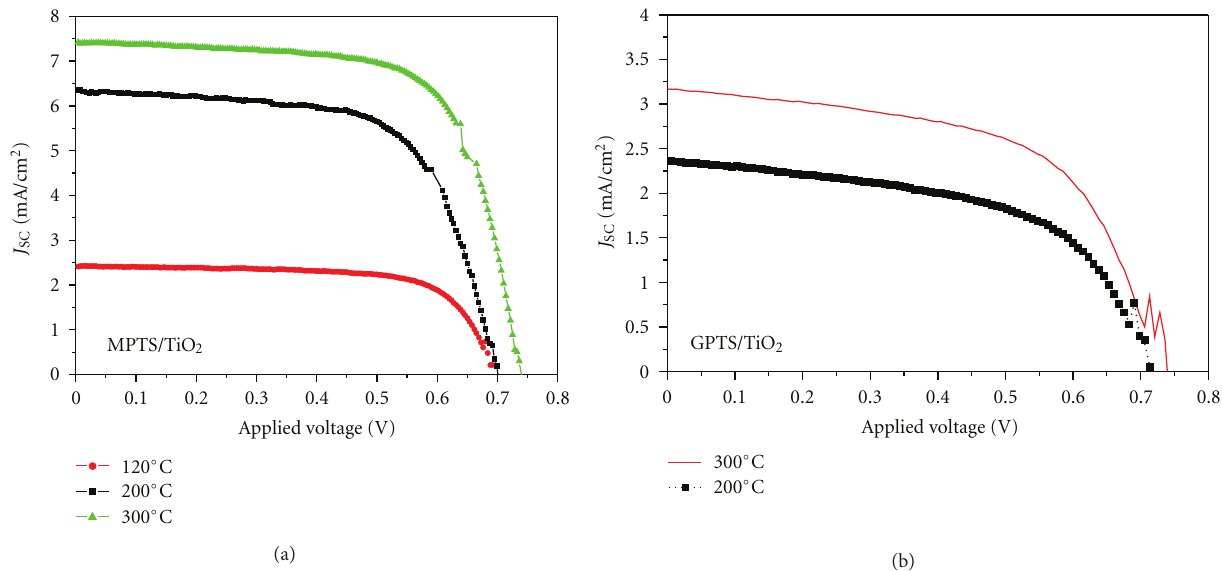
F 1: e JV curves for DSCs composed of MPTS-TiO annealing at different temperatures.